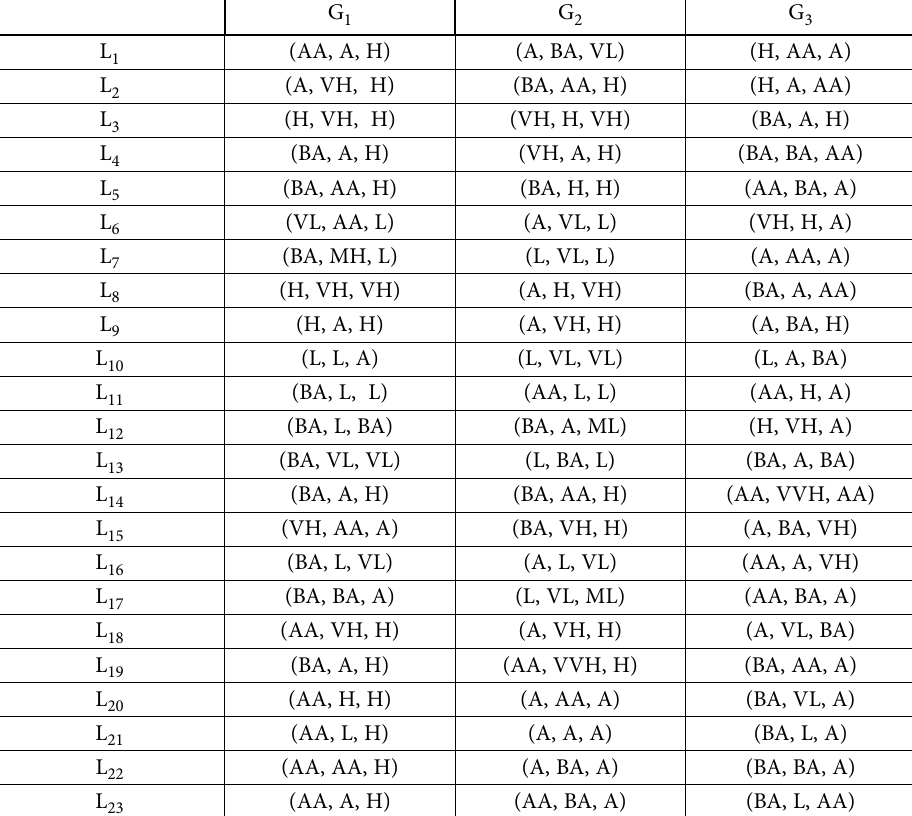
Table 5. LVs of alternative under different challenges to implement of G-IoT by DEs G 1 G 2 G 3 L 1 (AA, A,